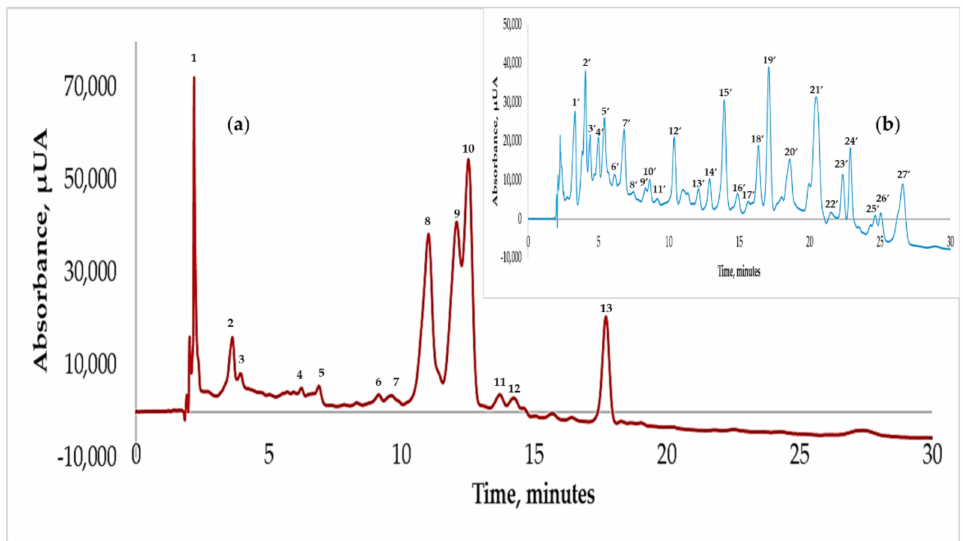
Figure 7. RP-HPLC-DAD ( λ = 320 nm) chromatograms for the flavonoids and polyphenols in the optimized sourdough ( a ), and the unfermented optimized dough ( b ), according to the elution pattern and the chromatographic conditions described in Section 2.4. The injection volume (IV) was 10 µ L and the concentration of the sample was 400 mg/mL. Peak’s identification: 4—vanillic acid; 9—ferulic acid; 5 (cid:48) —chlorogenic acid; 7 (cid:48) —vanillic acid; 13 (cid:48) —ferulic acid; 23 (cid:48) —quercetin, 24 (cid:48) —gallic